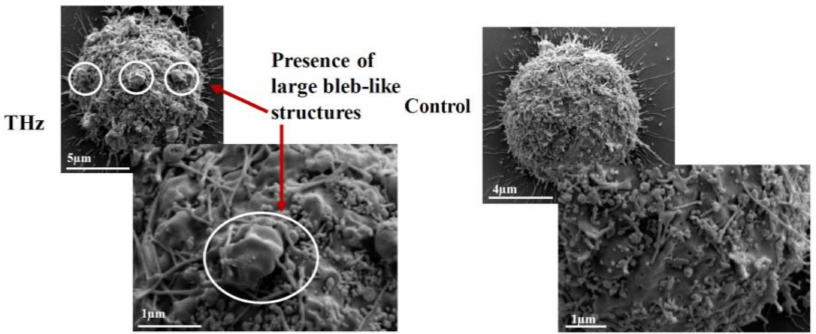
Figure 3. Scanning electron micrographs of PC 12 cells after 10 min of THz